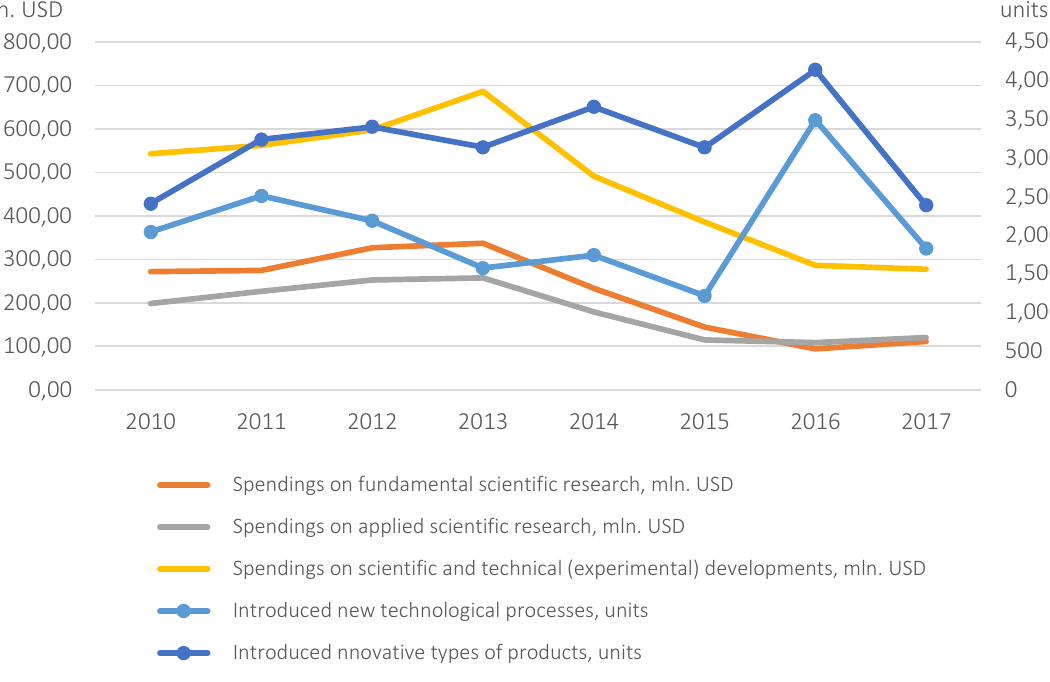
Figure 1. Innovation activity inflows and outputs in